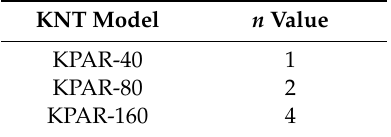
Table 2. Multification factor for di ff erent size of KNT